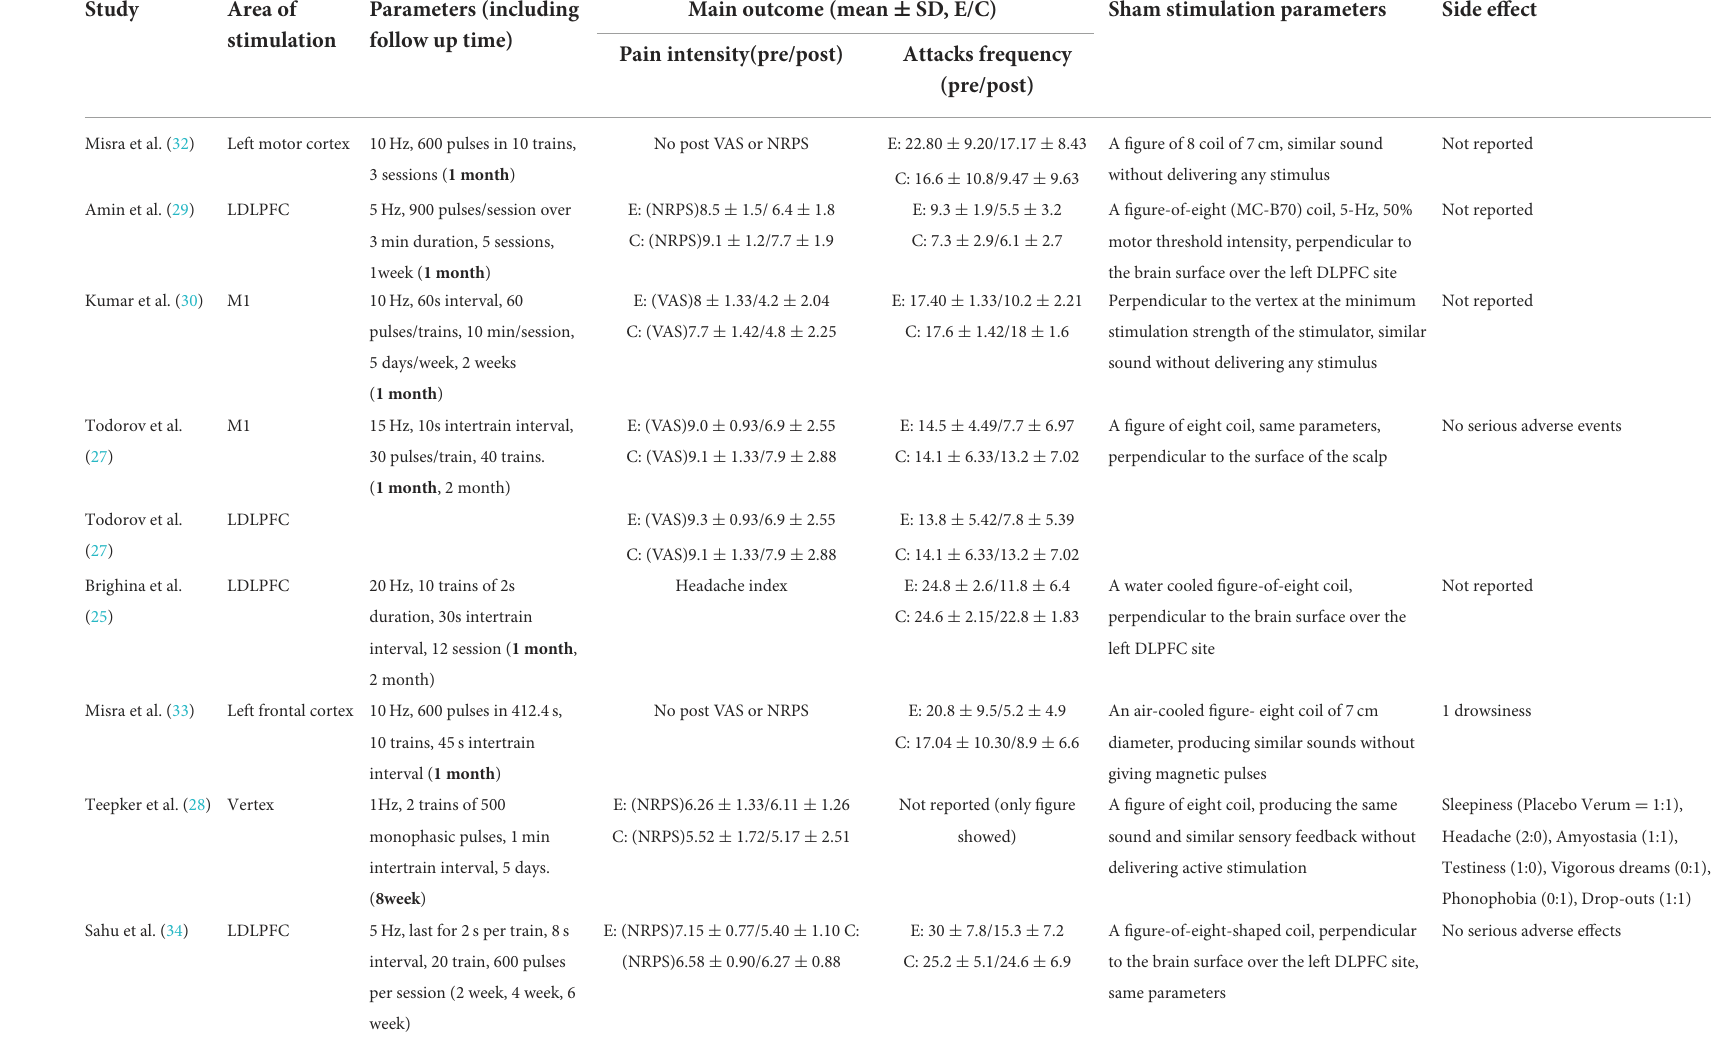
TABLE 3 Characterize of rTMS application.